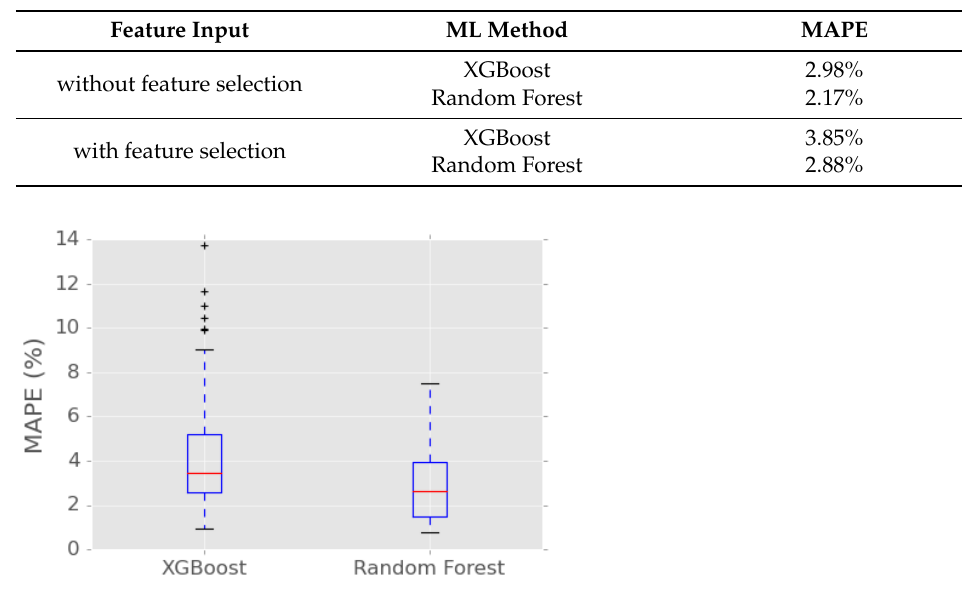
Table 3. Average MAPE.